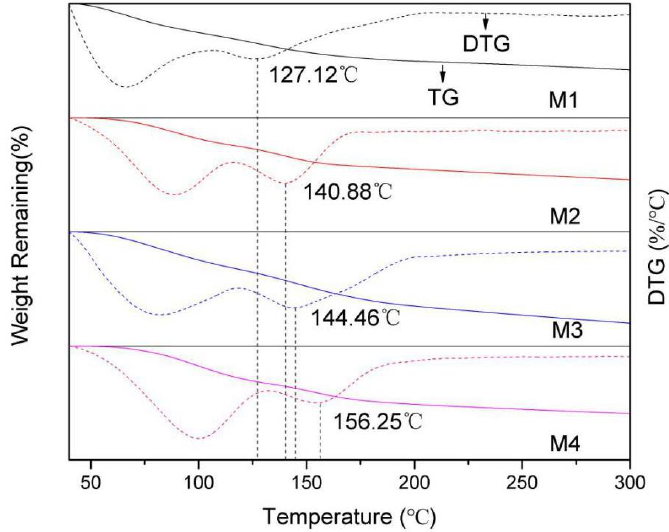
ff erent layer charge densities.